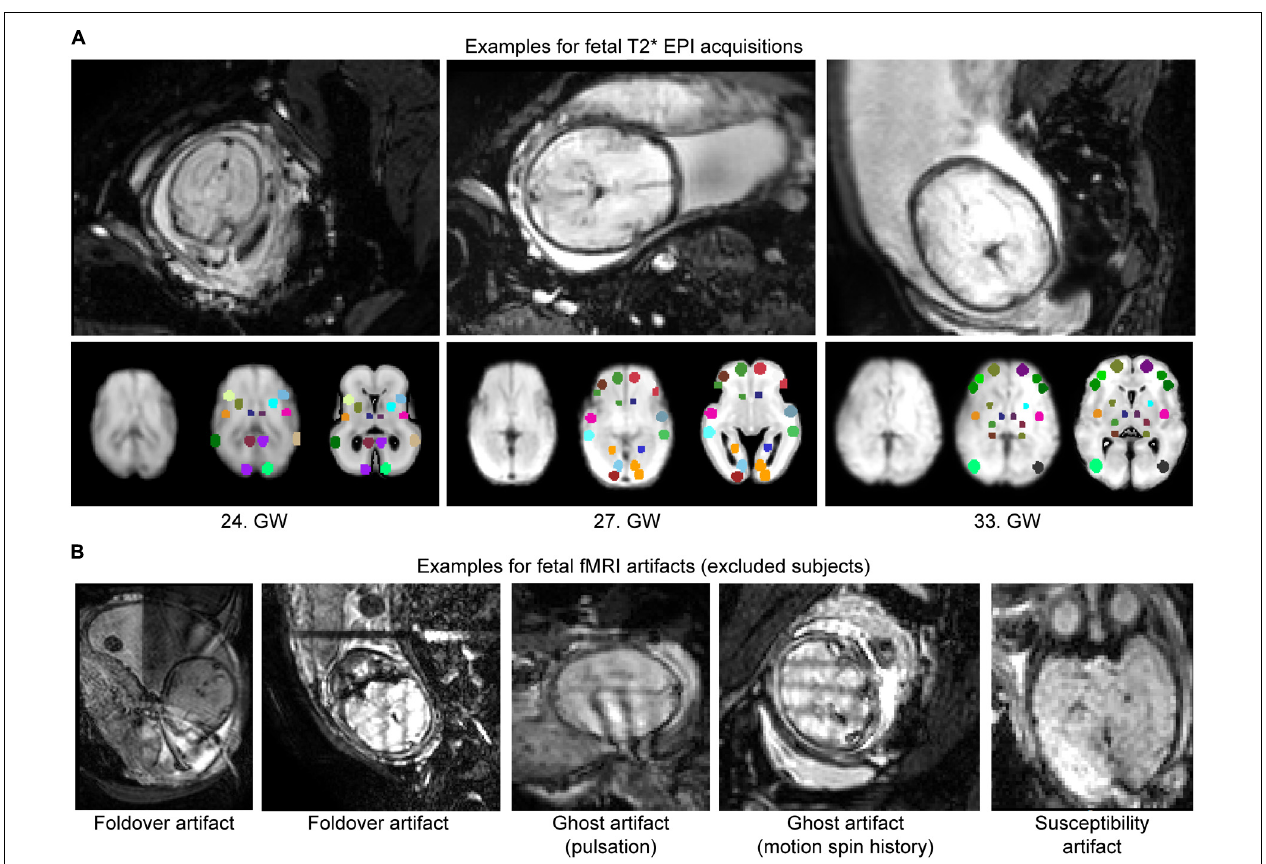
FIGURE 6 | Examples for fetal fMRI and the most common imaging artifacts. (A) Fetal fMRI with full FOV. Bottom panels: standardized functional image, ROI system warped to the standardized image and the fetal atlas systems illustrated. We provide 1–1 examples from the GWs